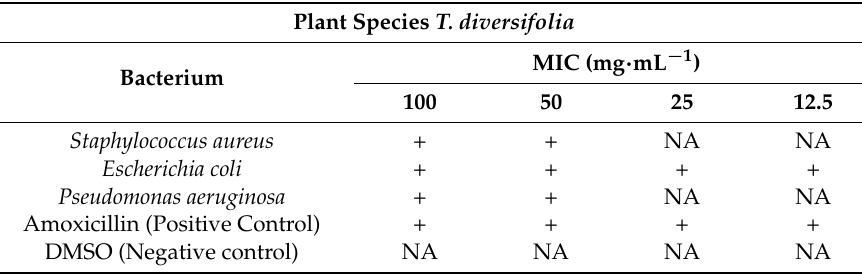
Table 13. Minimum Inhibitory Concentration (MIC) of OE T. diversifolia